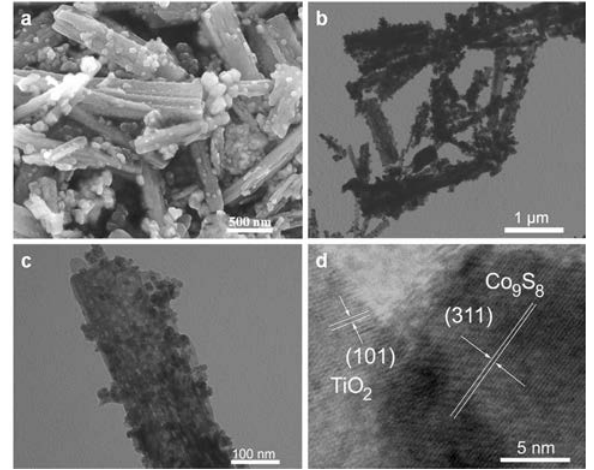
Figure 3. SEM image ( a ), TEM images ( b , c ) and HRTEM image ( d ) of the TiO 2 nanobelt@Co 9 S 8 composites.